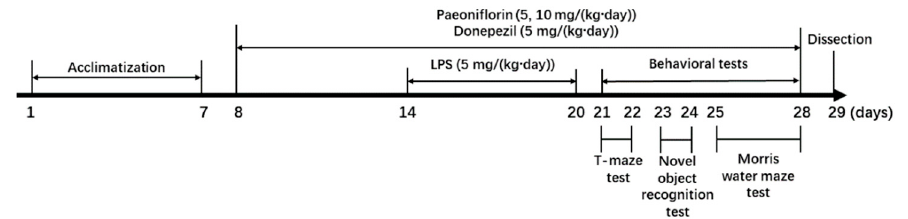
Figure 7. Experimental schedule.